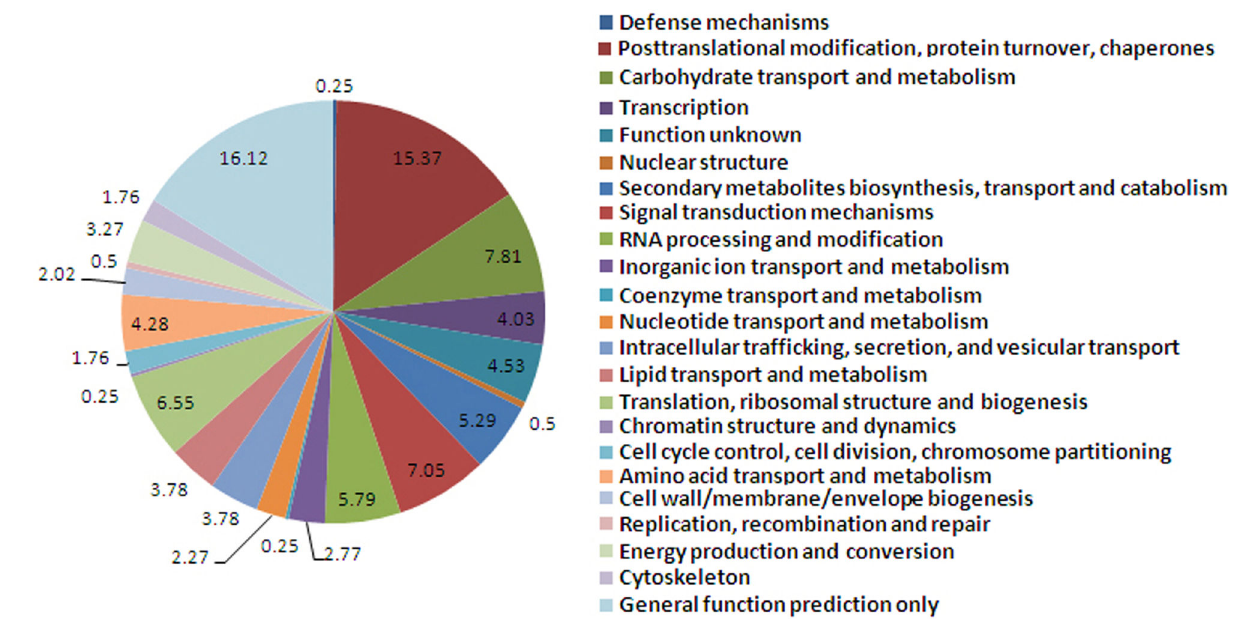
Figure 3. The functional classification of proteins deduced from plant homologous Unigenes in the SSH library using